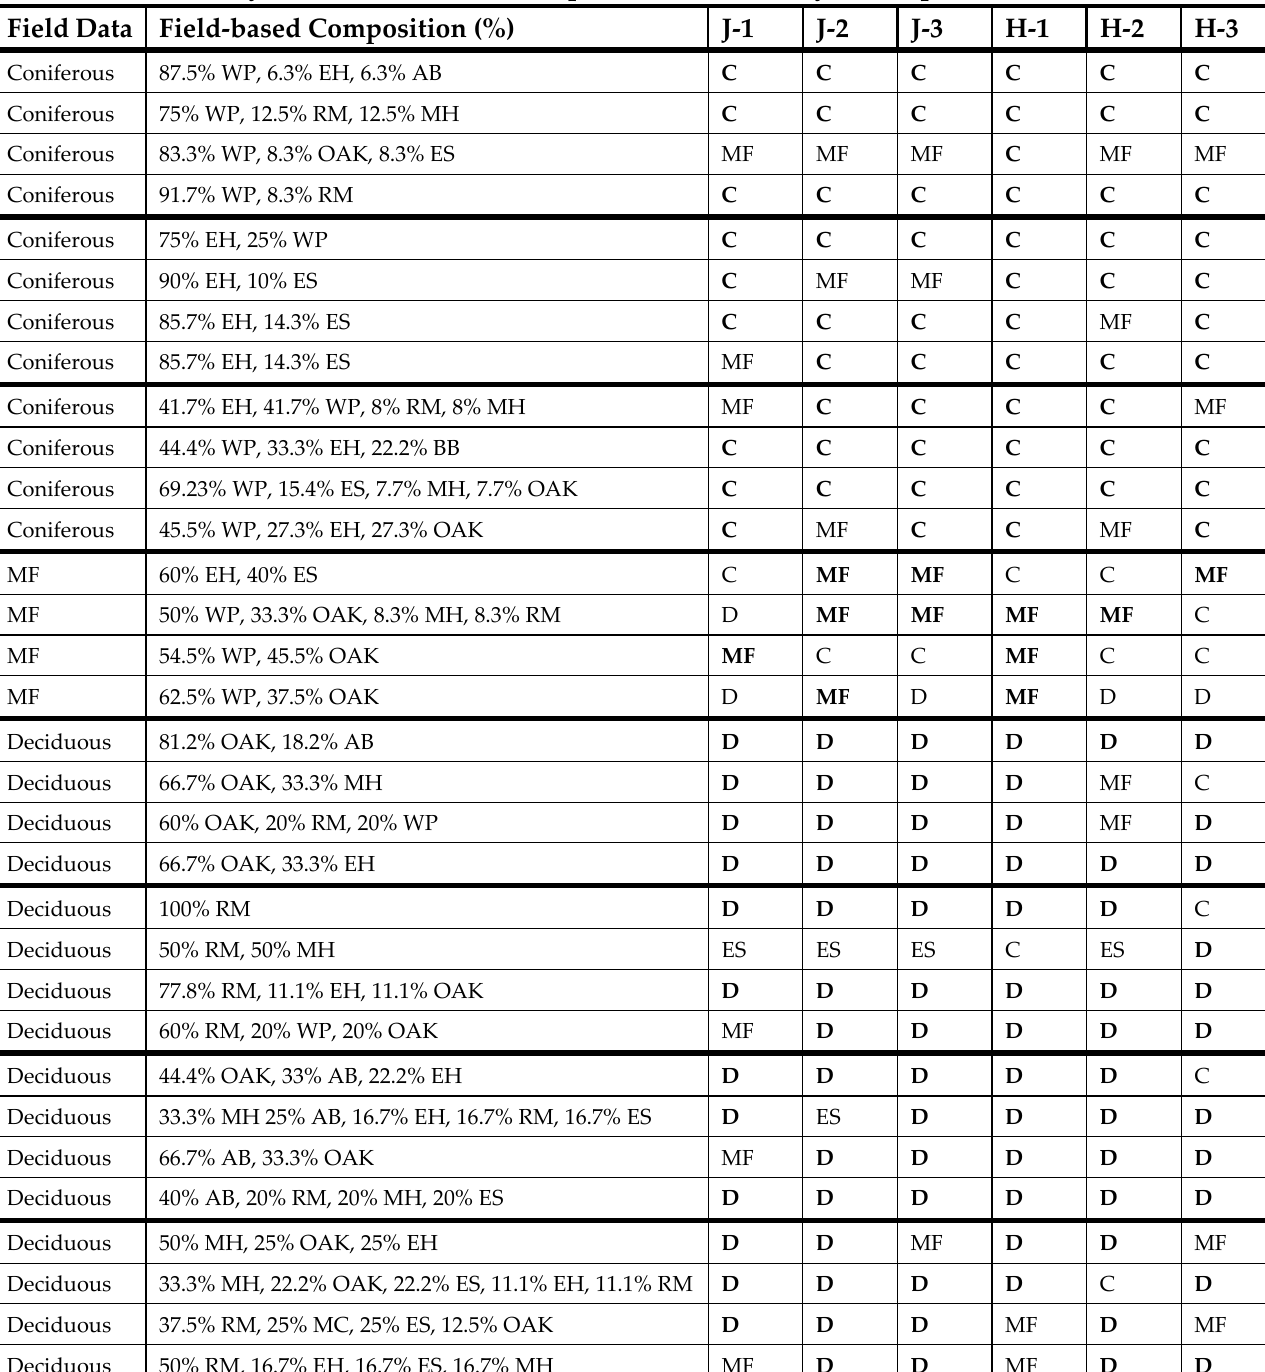
Table 5. Unmanned aerial system (UAS) qualitative assessment of visual interpretation uncertainty for individual forest inventory plots of varying species composition (four classes) across six trials. Note: the green box indicates agreement with the field data, while the red box indicates disagreement. The two visual interpreters are referenced as ‘J’ and ‘H’ with their three trials labeled each as ‘1’, ‘2’, and ‘3’. Composition classes found within this table include white pine (WP), eastern hemlock (EH), mixed conifer (MC), mixed forest (MF), oak mixtures (OAK), American beech (AB), red maple (RM), mixed